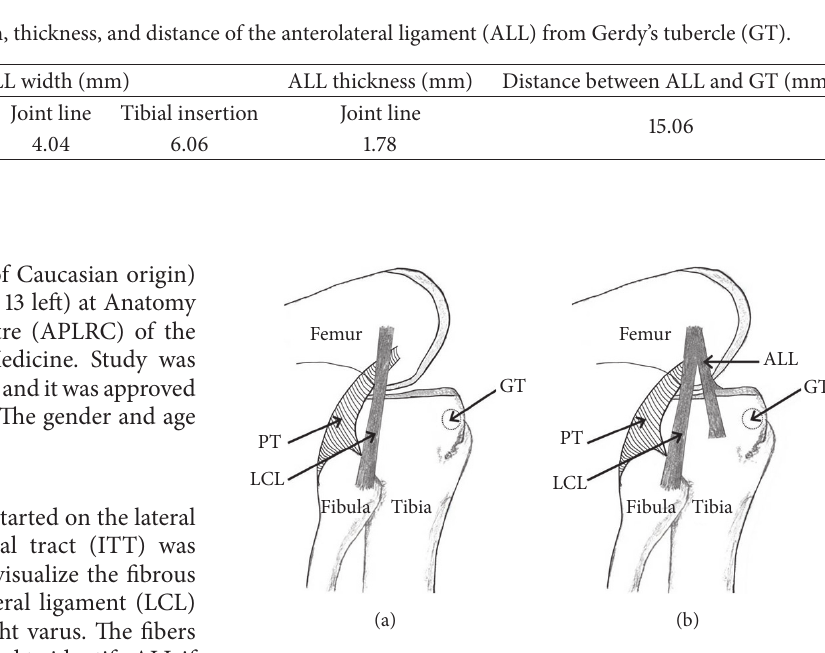
Figure 1: (a) Schematic drawing showing the LCL with no ALL present on the lateral knee. ALL: anterolateral ligament; LCL: lateral collateral ligament; PT: popliteus tendon; GT: Gerdy’s tubercle. (b) Schematic drawing showing the ALL (its proximal bifurcation from LCL) and its important relations on the lateral knee. ALL: anterolateral ligament; LCL: lateral collateral ligament; PT: popliteus tendon; GT: Gerdy’s